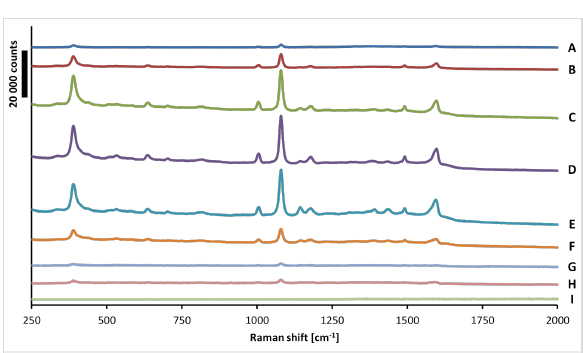
Figure 4: SERS spectra of 4-ATP molecules on A–I SSFs.